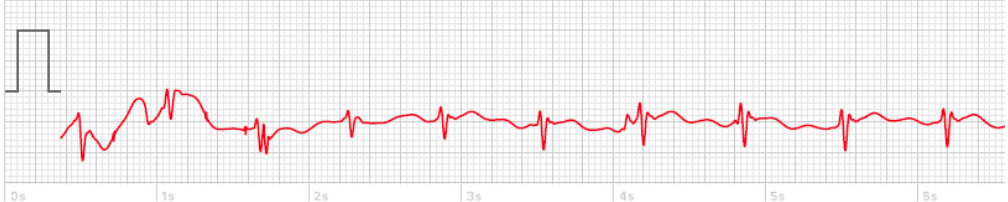
Figure 4. A sample of temporary artifact (around one second) due to instability of the Apple Watch 4 on a patient’s wrist. on a patient’s